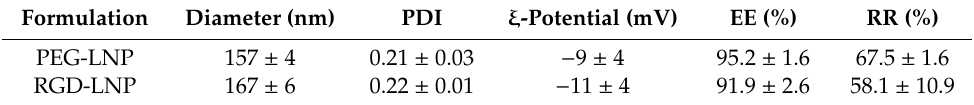
Table 1. Characterization of LNPs.